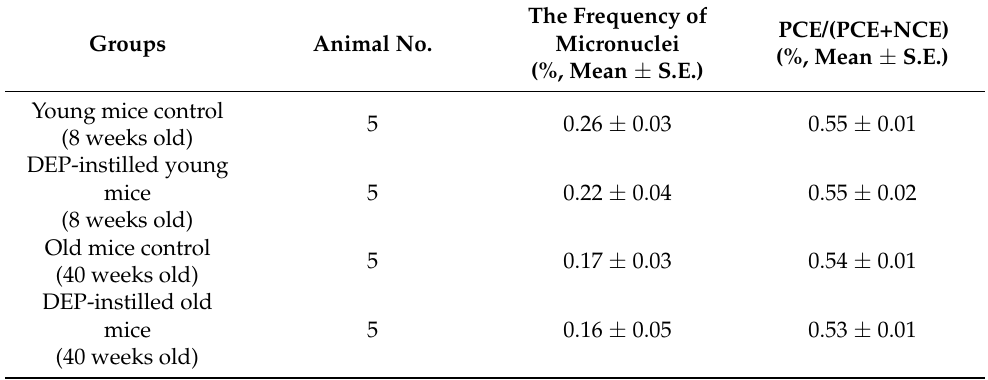
The Frequency of Micronuclei (%, Mean ± S.E.)